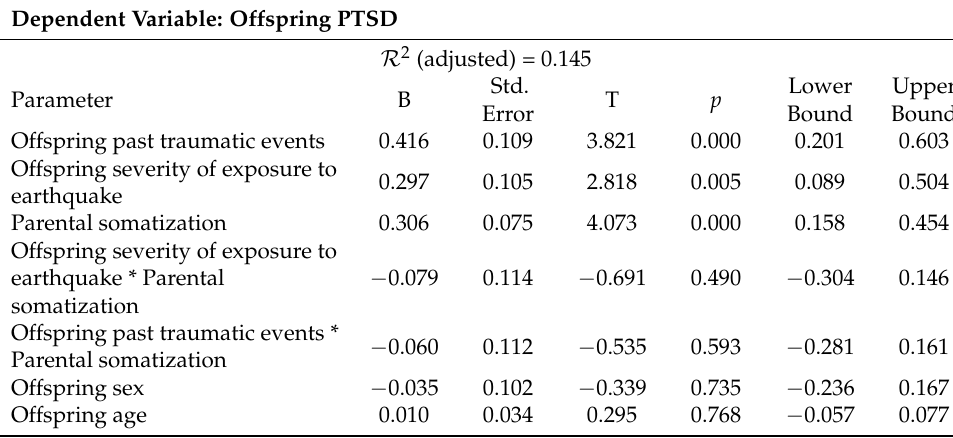
Table 3. General linear model for the PTSD-RI in the EA. Dependent Variable: Offspring